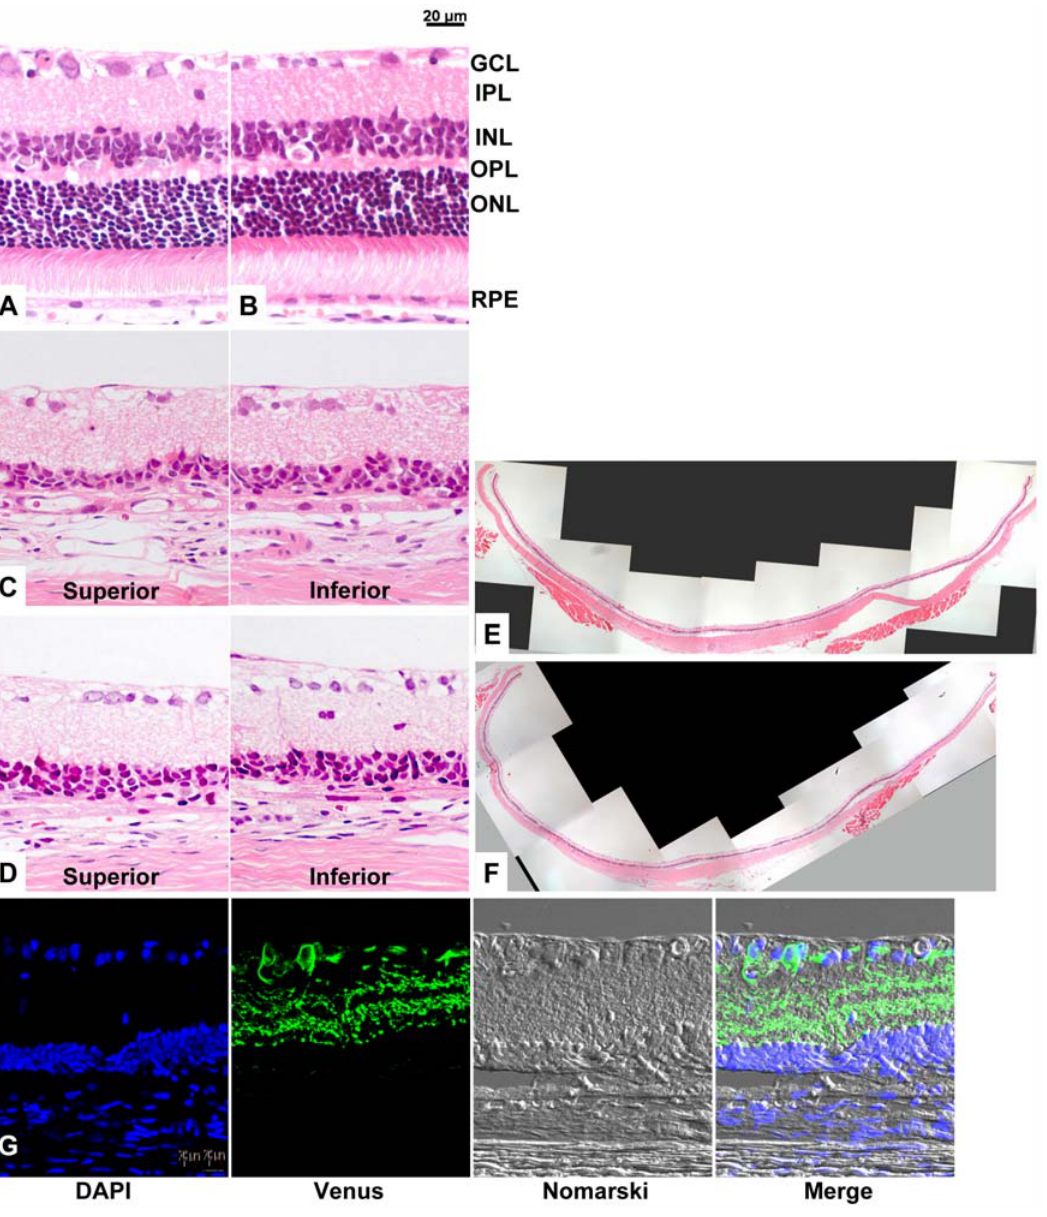
Figure 4. Morphological evidences of the photoreceptor degeneration in either ChR2V 2 / 2 or ChR2V + / 2 rats. (A, B) Normal retinal architecture was observed in each rat before photoreceptor degeneration. (C, D) After continuous light exposure (3000 lux for 7 days). Sections are from the superior and inferior regions at a distance of 0.24 mm from the optic nerve. Note the absence of the outer nuclear layer. (E, F)The severe degeneration extended to the whole retina. (G)Cryo-section of a retina from a ChR2V + / 2 rat. ChR2V expression was observed in the inner layer. Abbreviations: GCL, ganglion cell layer; IPL, inner plexiform layer; INL, inner nuclear layer; OPL, outer plexiform layer; ONL, outer nuclear layer; RPE, retinal pigment